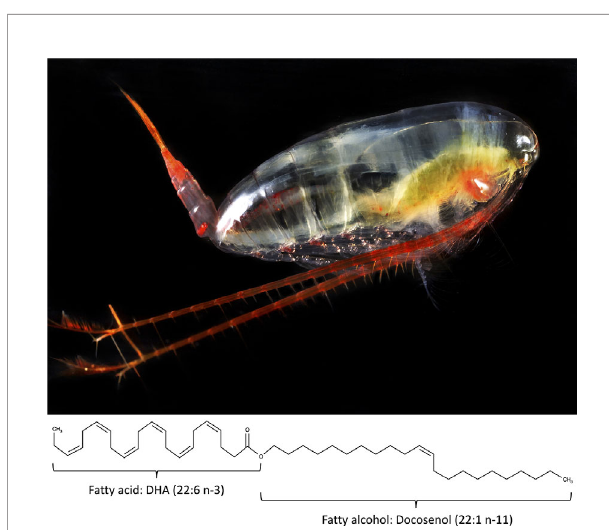
FIGURE 1 | The marine copepod Calanus fi nmarchicus and a wax ester composed of the long-chain polyunsaturated omega-3 fatty acid docosahexaenoic acid (22:6 n-3) bound to the long chain fatty alcohol docosenol (22:1 n-11) as an example of the lipids found in the oil of Calanus fi nmarchicus . Photo Copyright by Calanus